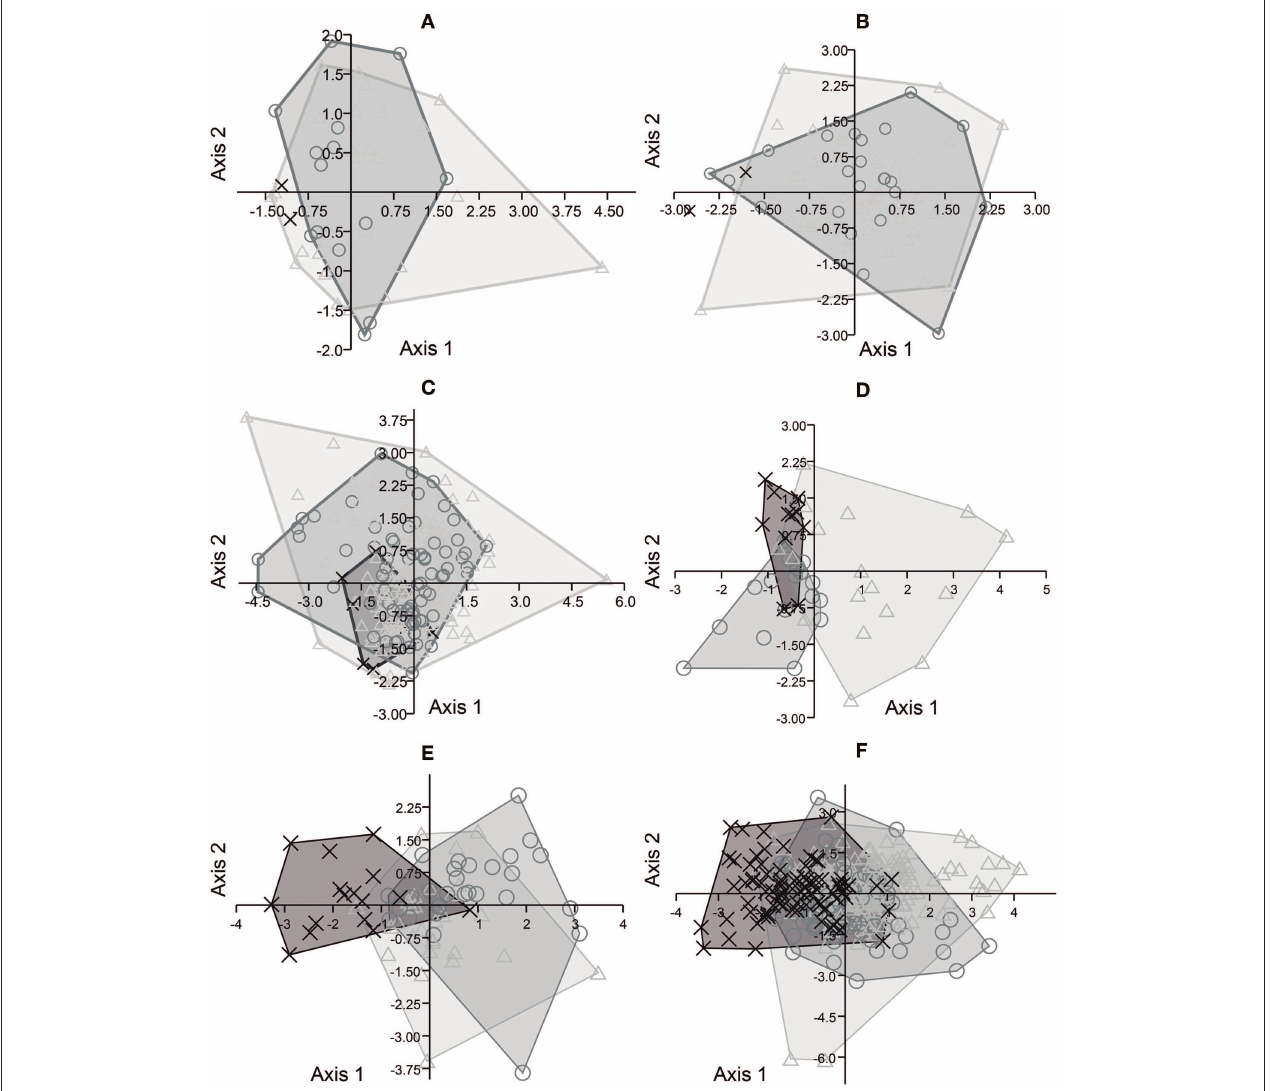
FIGURE 5 | Scatter plots from Canonical Variates Analysis based on three dimensions of upper cheek teeth of E. neogeus (circle), E. insulatus (triangle), and E. andium (x). Projected scores on: (A) axes 1 (93%) and 2 (7%) from the analysis of P2; (B) axes 1 (88%) and 2 (12%) from the analysis of M3; (C) axes 1 (71%) and 2 (29%) from the analysis of P3, P4, M1, and M2; (D) axes 1 (70%) and 2 (30%) from the analysis of p2; (E) axes 1 (90%) and 2 (10%) from the analysis of m3; and (F) axes 1 (86%) and 2 (14%) from the analysis of p3, p4, m1, and m2.